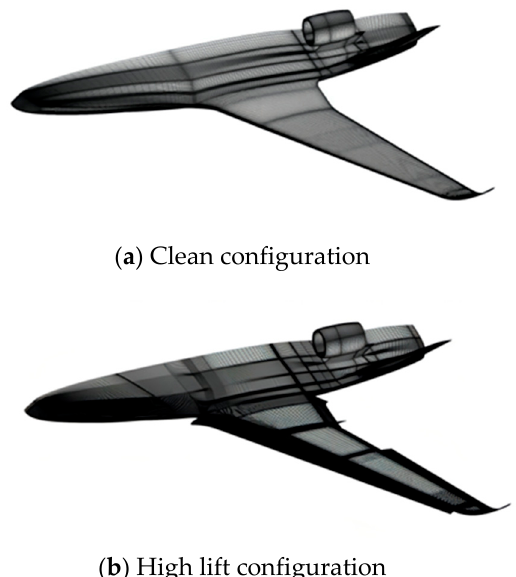
Figure 3. Surface grid of the configurations.